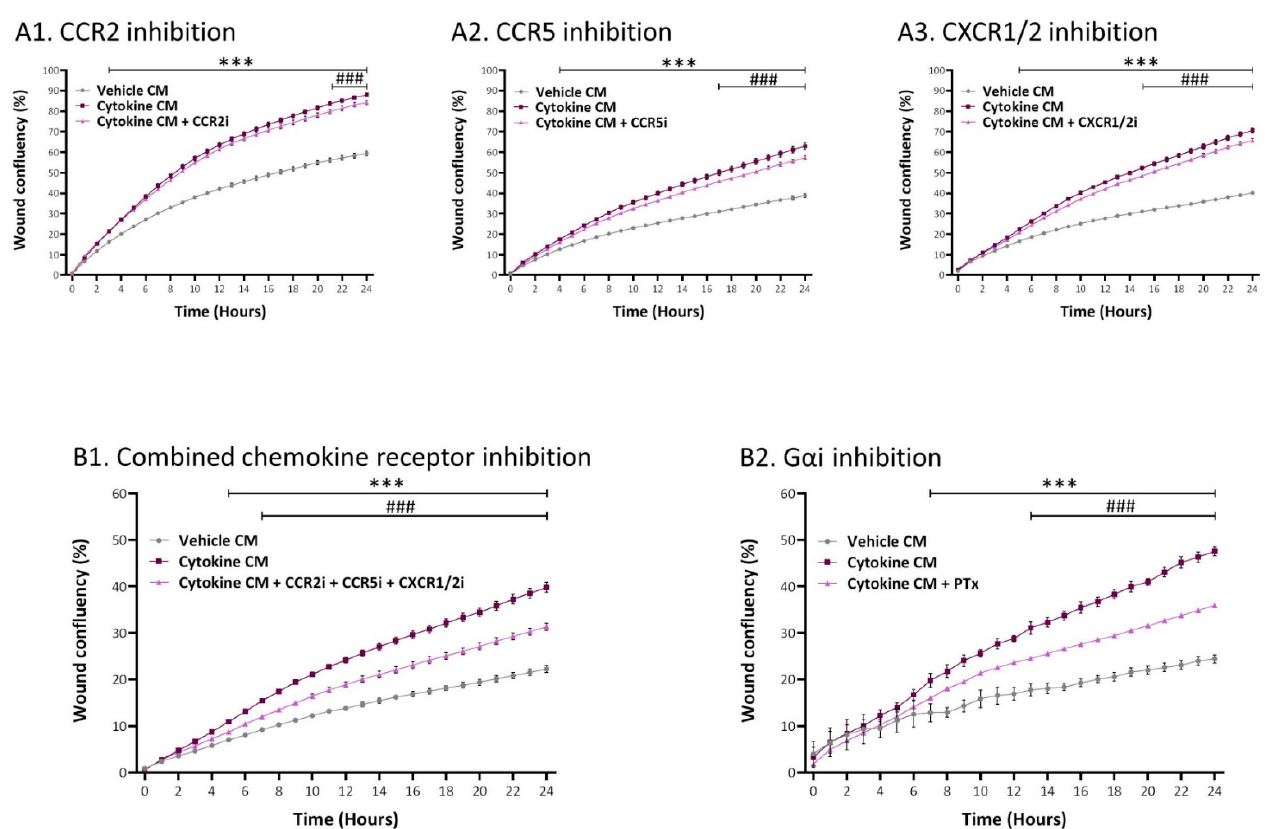
Figure 11. Tumor cell migration, elevated by inflammatory CAF-derived factors, is mediated through cooperativity between the chemokine receptors CCR2, CCR5, and CXCR1/2. Human MSCs were exposed to persistent TNF α + IL-1 β stimulation (concentrations as in Figure 1) or to vehicles, generally for 14–18 days. Cytokine-devoid CM were collected as described in Figure 7 and were administered to MCF-7 cells in the presence of inhibitors. ( A ) Chemokine receptor